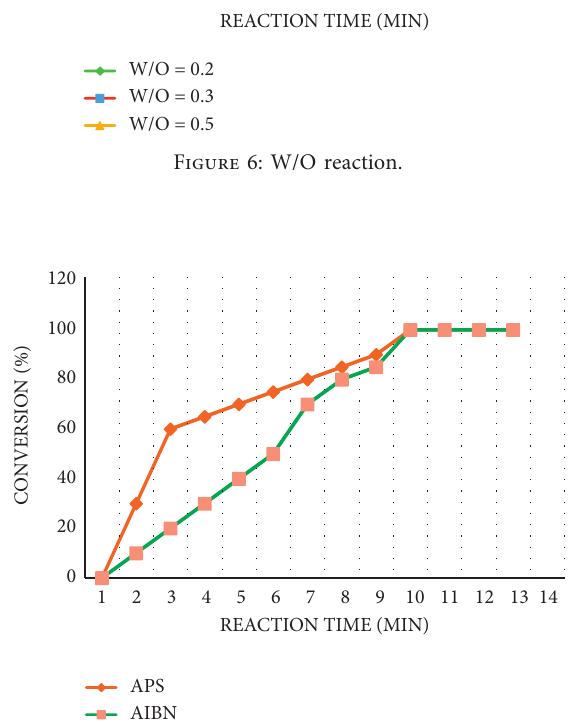
Figure 7: Different initiator